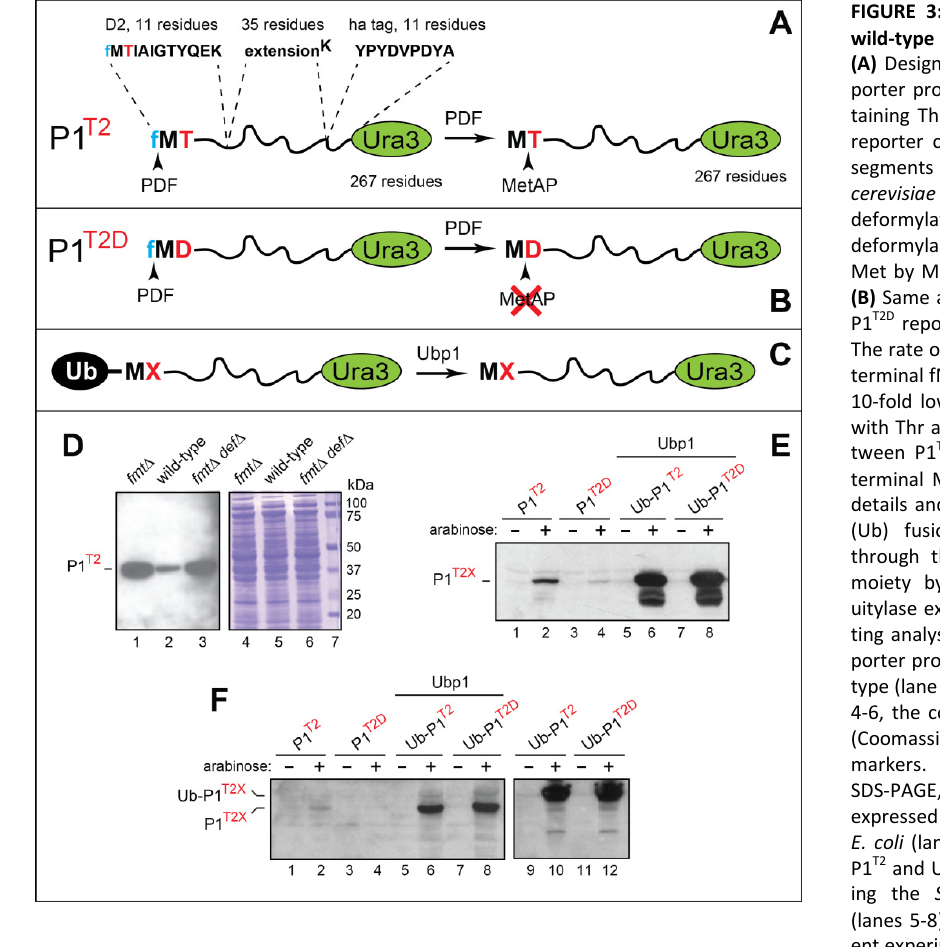
FIGURE 3: Analyses of reporter proteins in wild-type and formylation-lacking fmt E. coli